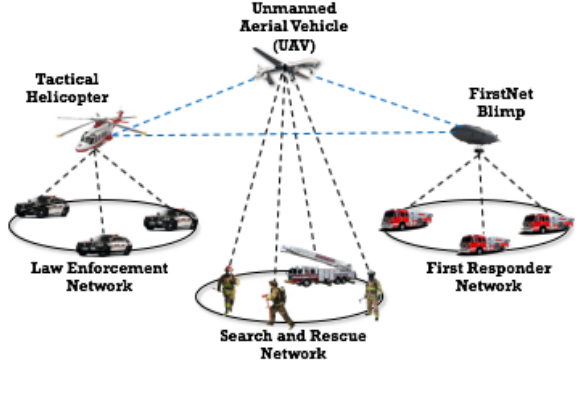
Figure 15. Distributed SDN